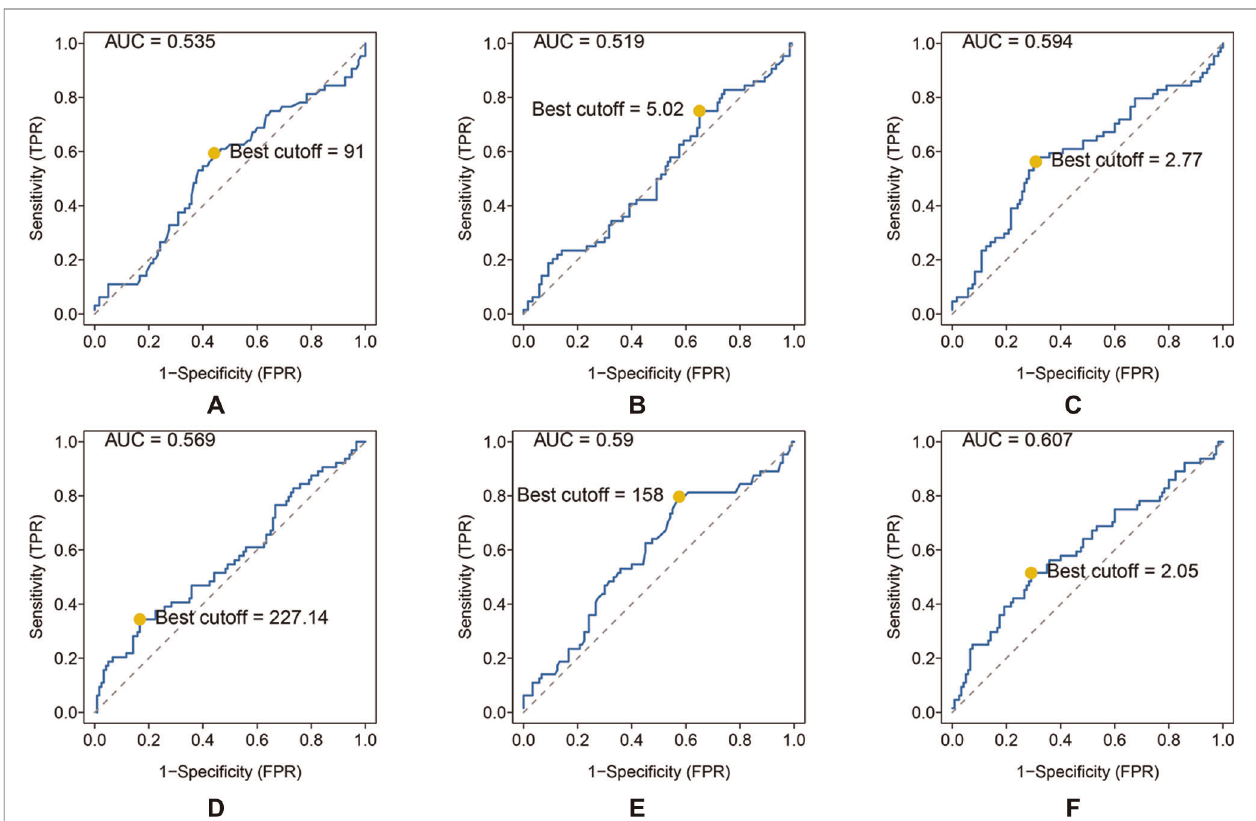
FIGURE 1 | ROC analysis of different hematological biomarkers. ( A – F ) The AUC and best cutoff values of ALP, LMR, NLR, PLR, LDH, and dNLR are shown, respectively. The vertical axis represents the sensitivity and the horizontal axis represents the 1-speci fi